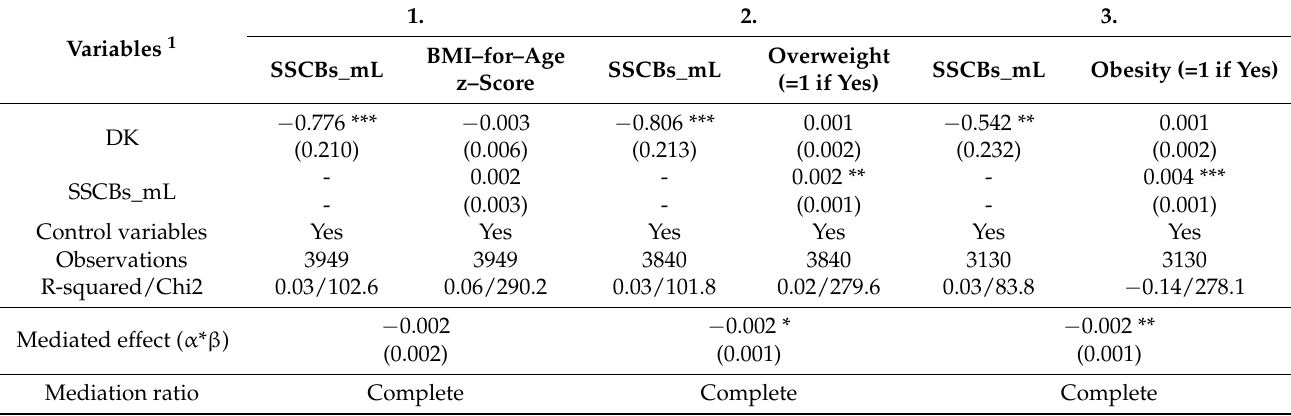
Table 4. Mediation analysis based on standardized regression weights from simultaneous equation modeling with SS- CBs_mL as a mediator (for the entire sample).